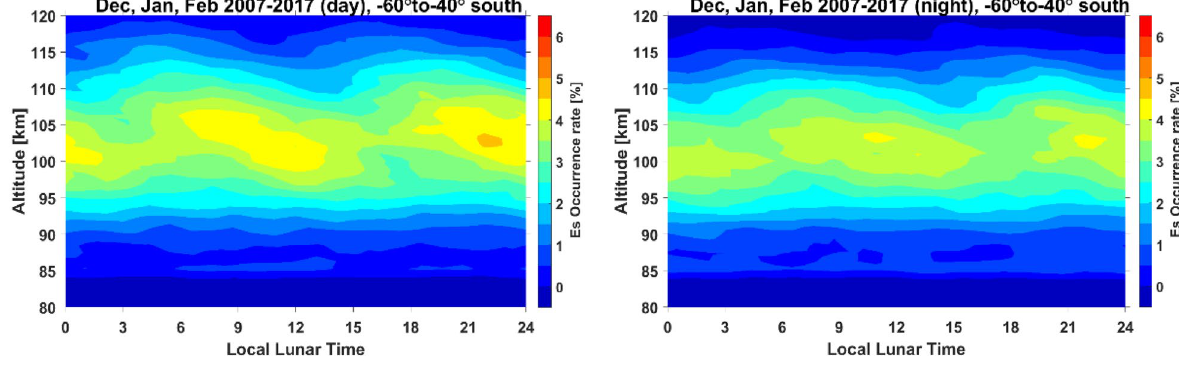
Figure b Mid-latitude EsOR variations during southern hemisphere summer with lunar local time at day (left) and night